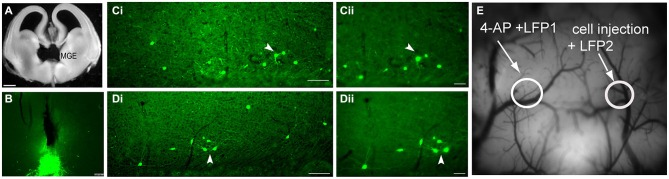
Transplantation of green fluorescent protein (GFP)-positive embryonic medial ganglionic eminence (MGE) cells into the adult cortex results in long-term survival, migration, and arborization. (A) MGE dissection in an E13.5 embryo. (B) Photomicrograph of a coronal brain section from an α4+/+ mouse demonstrating residual clustering of MGE neurons 30 days post-transplantation at the site of injection (see Methods for stereotaxic coordinates). Scale bar: 100 µm. (C,D) Low-power photomicrographs (scale bar: 100 µm) of coronal brain sections from α4+/+
(Ci) and α4−/−
(Di) mice demonstrating that transplanted GFP+ neurons migrate from the site of injection and form comparable arborization patterns. The transplanted MGE progenitors migrated throughout the cortex, and as far as 1 mm from the injection site. (Cii–Dii) Higher magnification images (scale bar: 50 µm) of the area indicated by the white arrowhead in (Ci,Di) shows that the transplanted interneurons have processes similar to mature neurons. (E) Image of the cortical surface indicating the locations of the LFP1 electrode, the 4-AP injection site, the LFP2 electrode, and the MGE/control cell injection site.